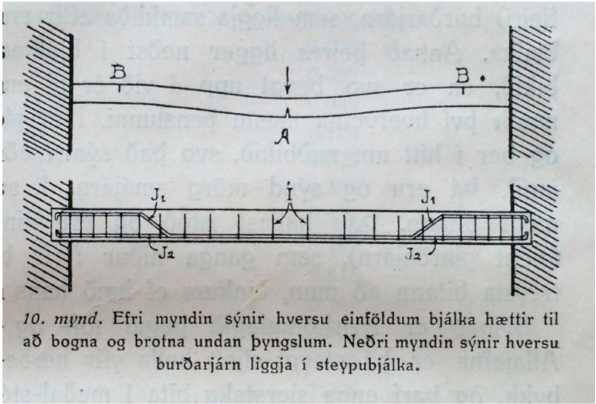
Figure 7. Guðmundur Hannesson, Steinsteypa: Leiðarv í sir fyrir alþ ý ðu og viðvaninga , 1921. Explanation of the position of iron bars. Copy available at the Reykjav í k City Library.